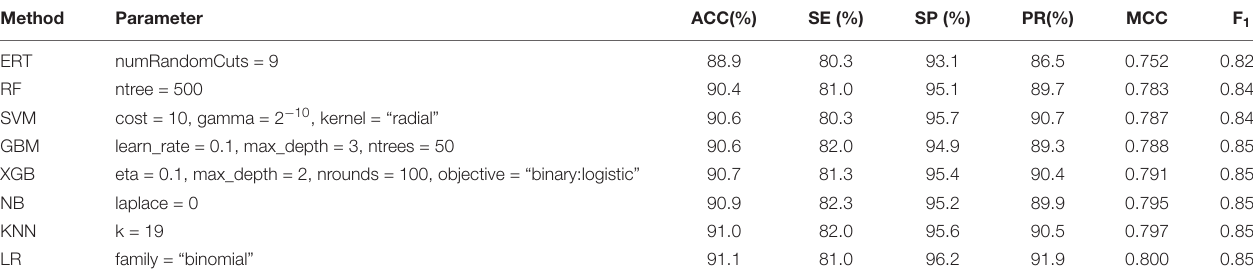
TABLE 2 | Performance comparison of eight types of meta-classifiers in the second stage on Train-915 dataset using 5-fold cross validation. Method Parameter ACC(%) SE (%)